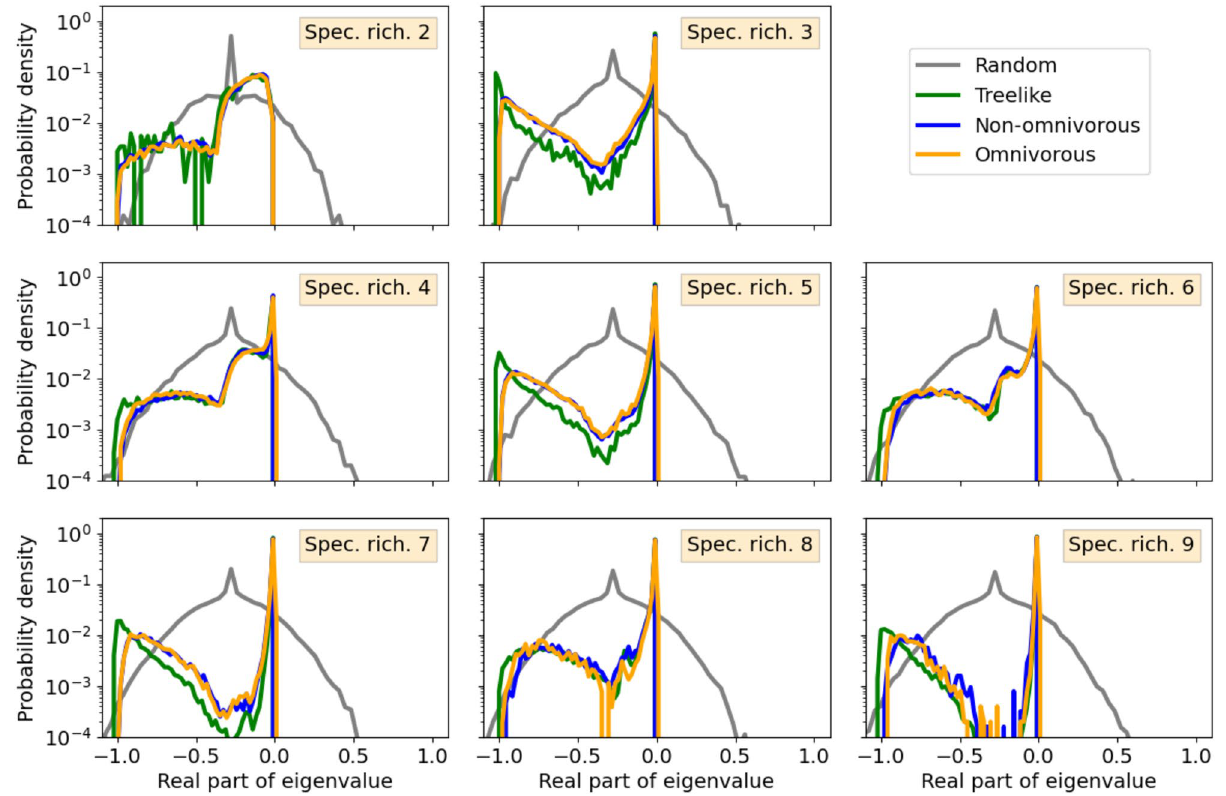
Figure 5. Distribution of eigenvalues along the real axis. Normalised frequency distributions of eigenvalues along the real axis for all food web structures and random matrices for species richness 2 − 9 . Eigenvalues representing food webs are taken from simulations using a range of values of β (Table 1), since varying β does not have significant effects on the real-part distributions ( Details: Sec. S6). All distributions are scaled to start in − 1 . Note the logarithmic vertical axis